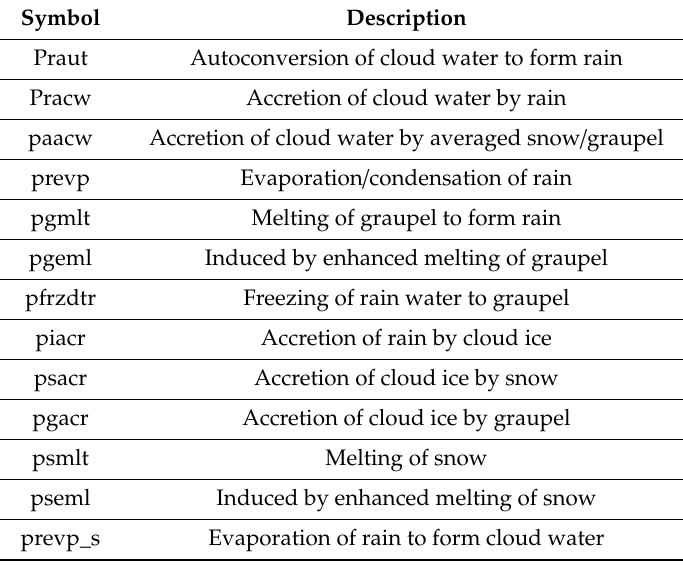
Table A1. List of